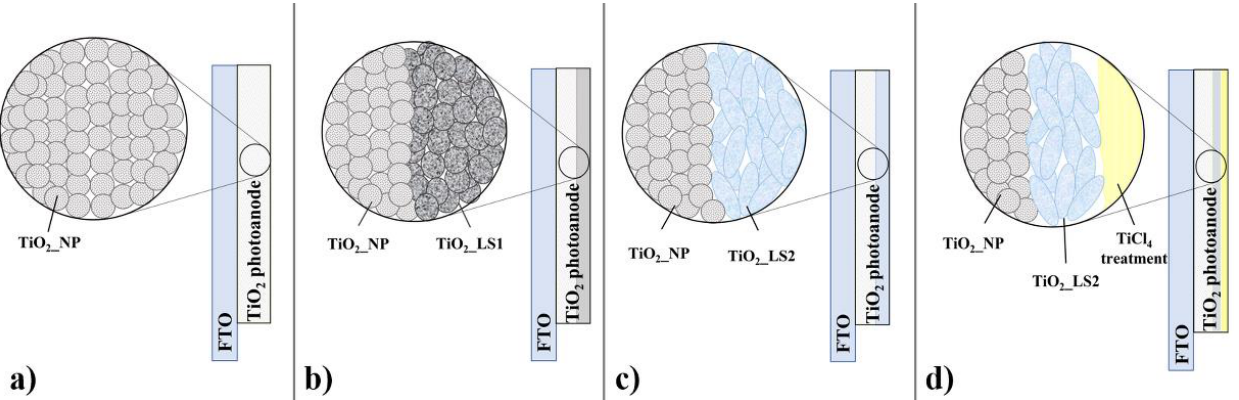
Figure 2. Schematic representation of the layer configuration in ( a ) PhA 1, ( b ) PhA 2, ( c ) PhA 3, and ( d ) PhA 4 photoanodes.